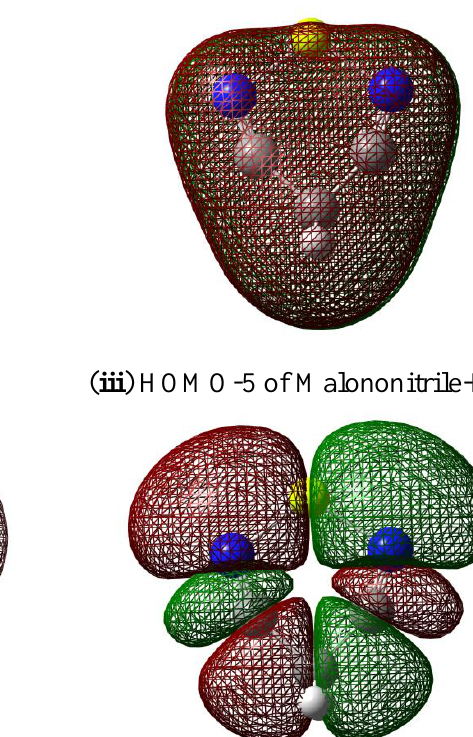
Figure 10. Selected molecular orbitals of malononitrile ( i ) and ( ii ); malononitrile-Be(II) complex ( iii ) and ( iv